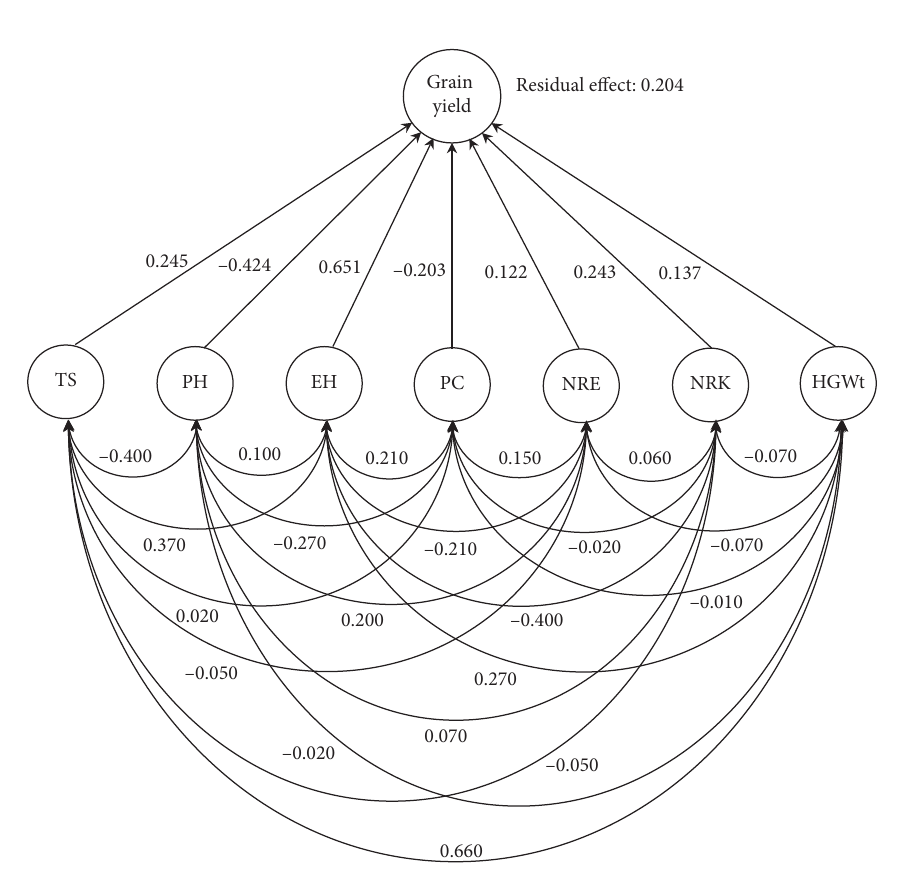
Figure 1: Average genotypic path coefficient diagram representing cause and effect relationships among quantitative traits and grain yield (TS: days to 50% tasseling; PH: plant height; EH: ear height; PC: plant count; NRE: number of kernel-rows per ear; NKR: number of kernels per row; HGWt: hundred-grain